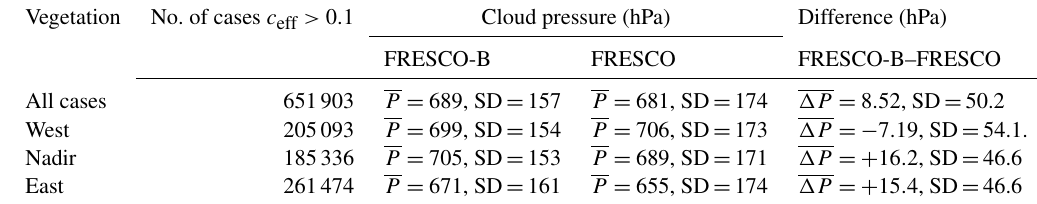
Table 6. Mean cloud pressure for FRESCO-B and FRESCO, as well as the difference between them, for GOME-2B measurements in July 2014 over vegetation. We distinguish the eastern (pixels 1 to 8), nadir (pixels 9 to 16) and western (pixels 17 to 24) parts of the swath .